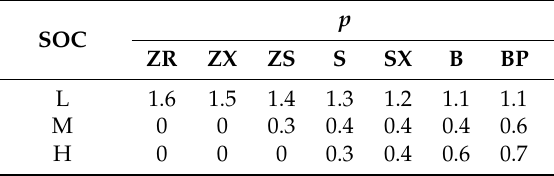
Table 3. Fuzzy logic control (FLC) rule base.